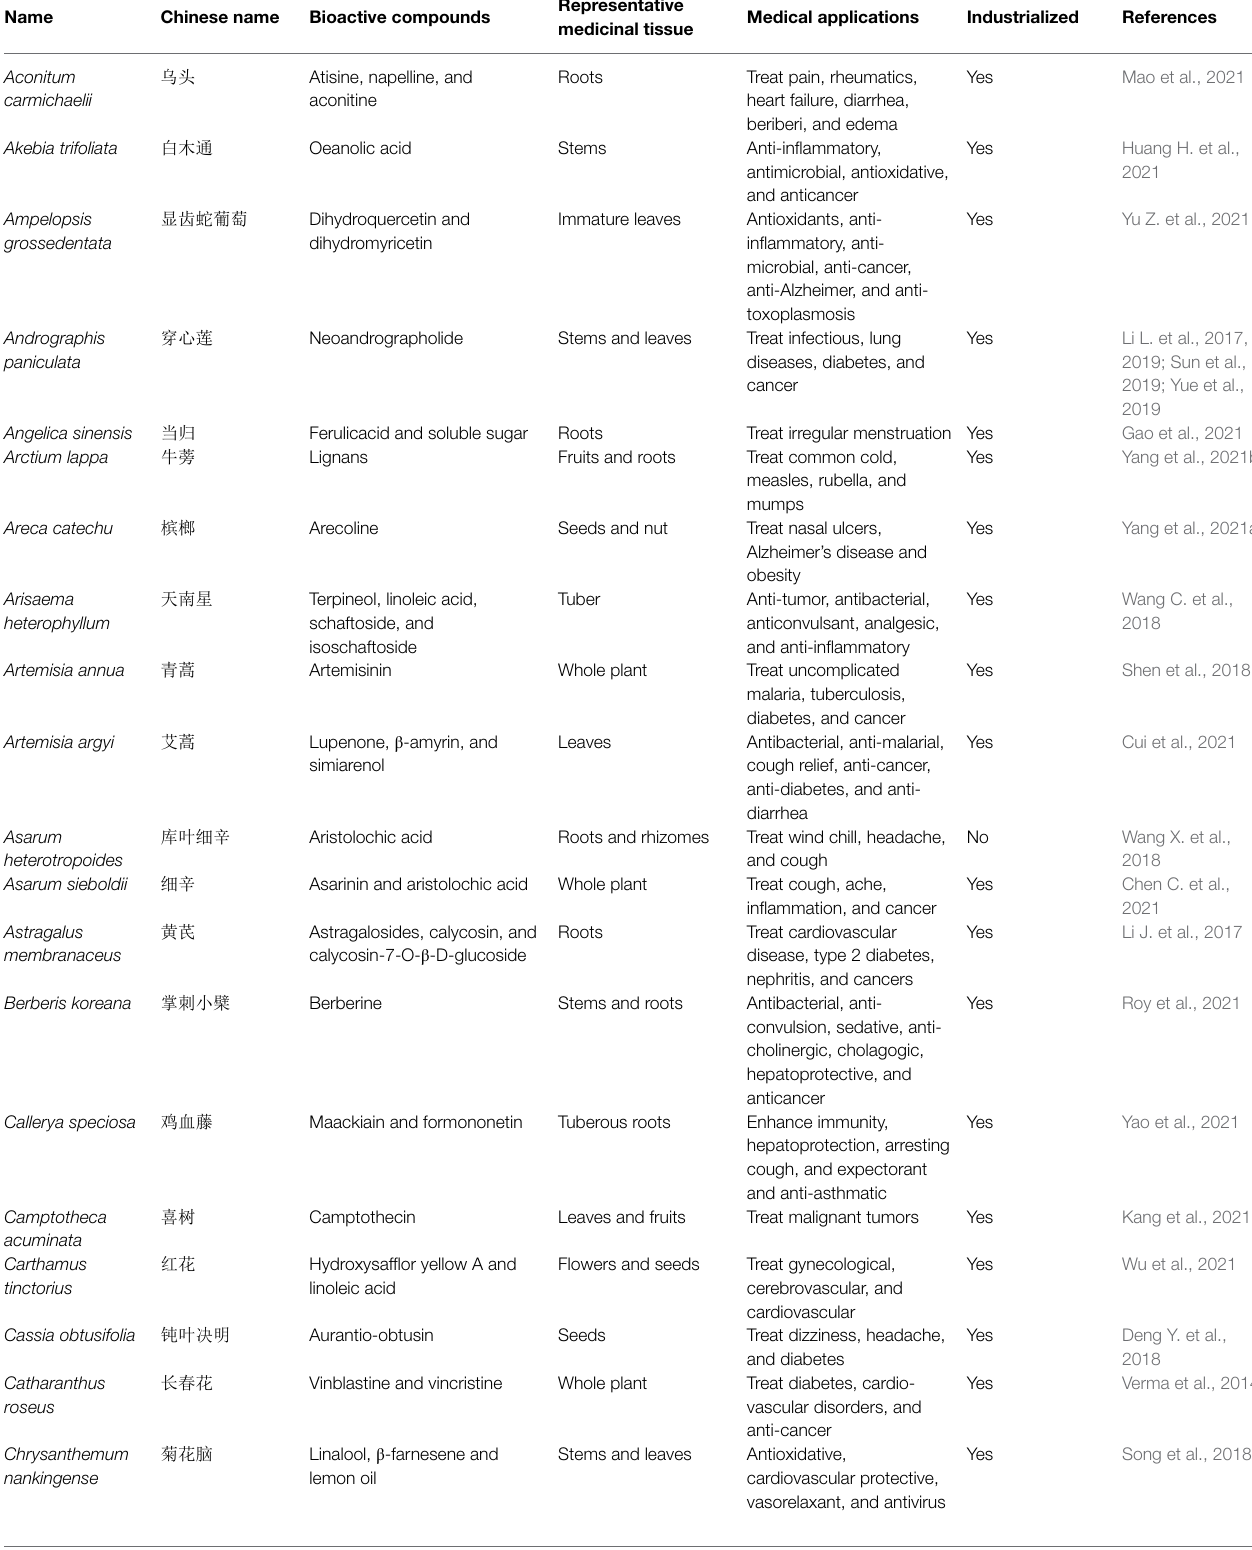
TABLE 2 | Characteristics summary of the